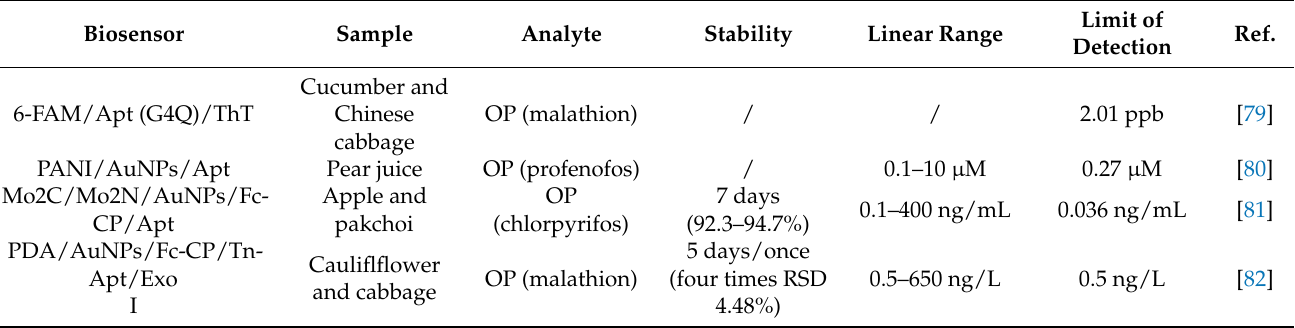
Table 5. Representative studies of aptameric biosensors for detecting pesticides from food